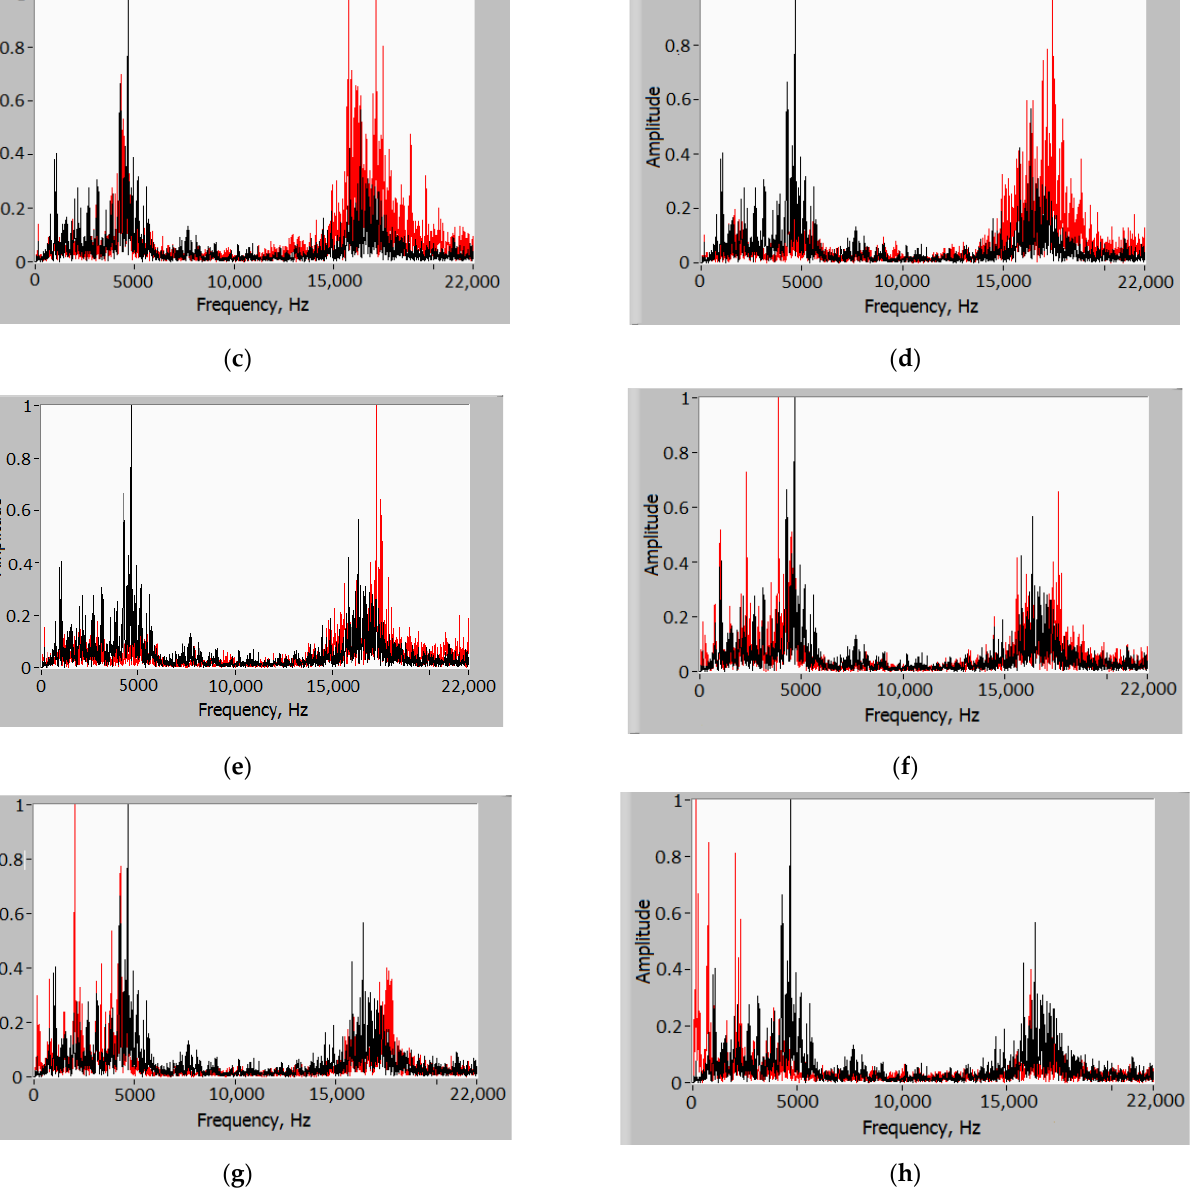
Figure 11. Comparison of the spectra of acoustic signals of the pipeline at a pressure of 2 bar (the spectrum of a defect–free pipeline is indicated in black; the spectrum of a pipeline with a leak is indicated in red): ( a ) for a defect diameter of 1 mm, ( b ) for a defect diameter of 2 mm, ( c ) for a defect diameter of 3 mm, ( d ) for a defect diameter of 4 mm, ( e ) for a defect diameter of 5 mm, ( f ) for a defect diameter of 6 mm, ( g ) for a defect diameter of 7 mm, ( h ) for a defect diameter of 8